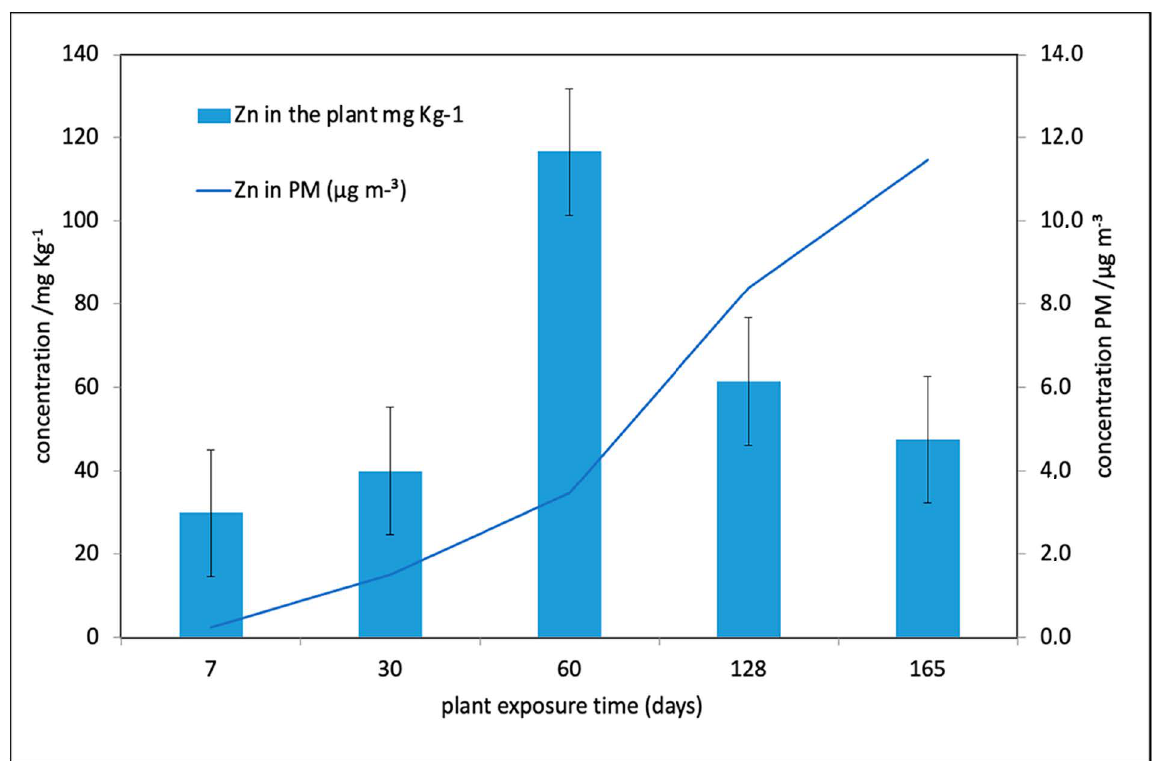
Figure 7. Concentrations trends for Zn in Chlorophytum comosum specimens exposed at the ARPA monitoring station in Milano Via Pascal compared with Zn concentrations determined in the aerosol particulate matter (PM10) for the same periods.